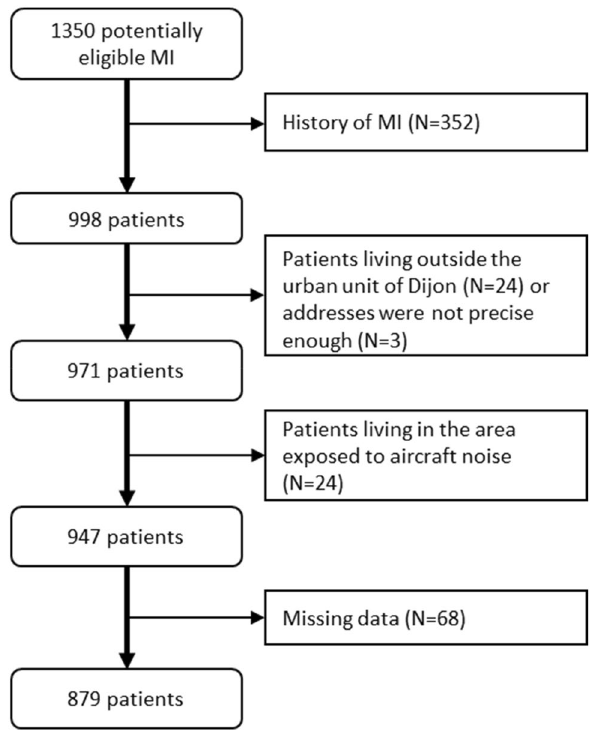
Figure 1. Flow chart of patient